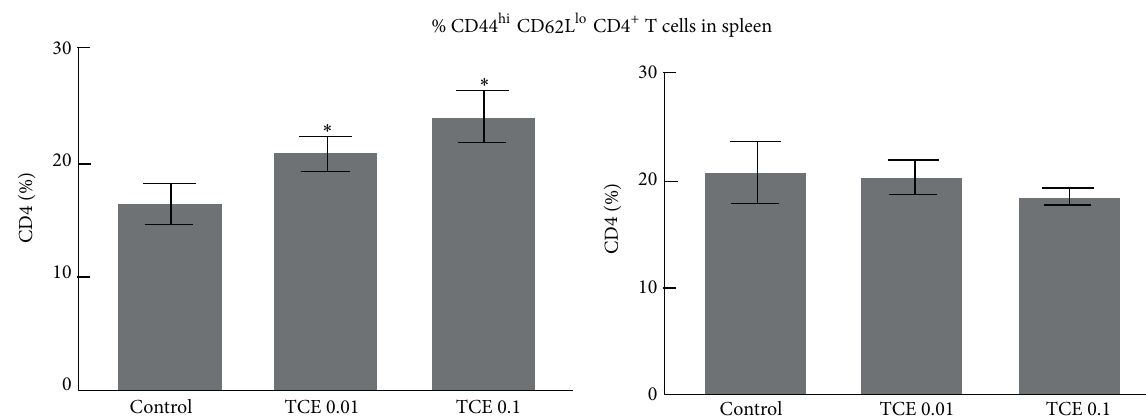
Figure 3: TCE enhanced the percentage of memory/activated CD4 + T cells following early life exposure. Spleen cell suspensions from PND49 mice that had been exposed to TCE during gestation only or during early life only were examined by flow cytometry to determine the percentage of CD4 + T cells that expressed high levels of CD44 and low levels of CD62L. ∗ Significantly different ( 𝛼 < 0.05 ) compared to control